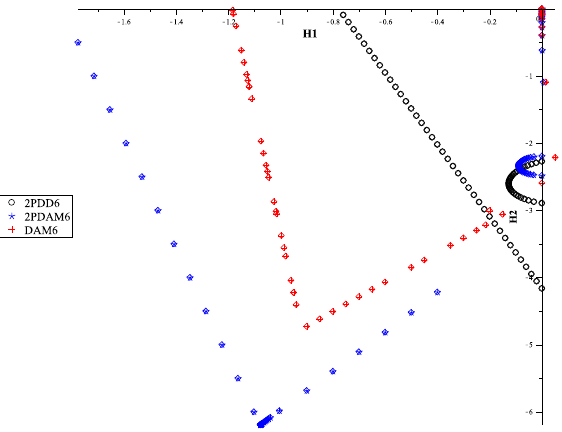
Figure 3. Comparison of the stability regions between 2PDD6, 2PDAM6 , and